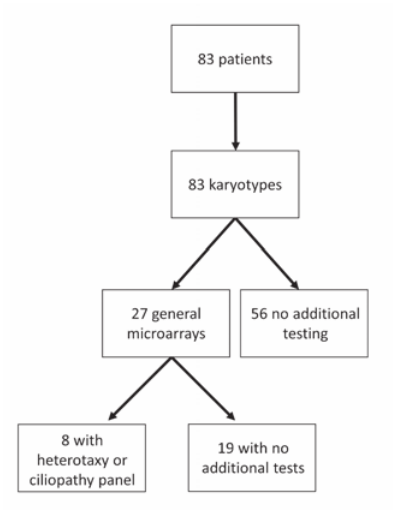
Figure 1. Flowchart illustrating testing done in the